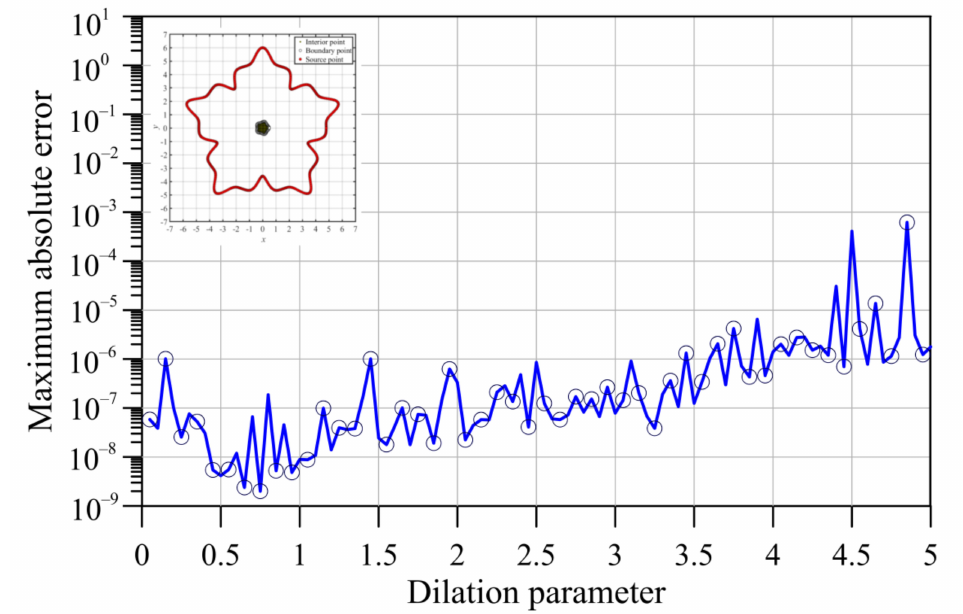
Figure 20. Maximum absolute error versus the dilation parameter ( k = 10 )